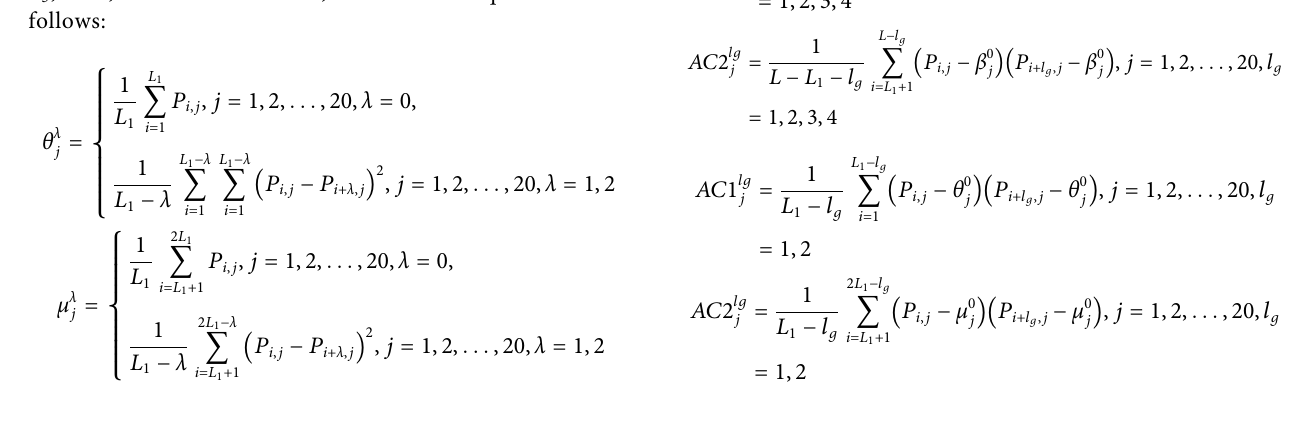
Frontiers in Genetics |